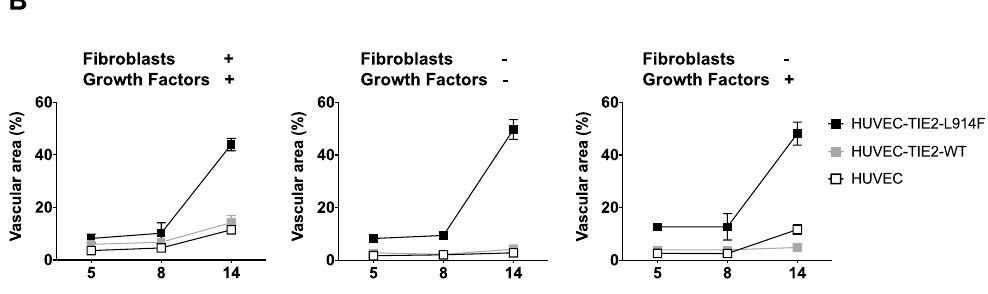
To characterize the ectatic vascular channels formed by the HUVEC-TIE2-L914F, we assessed the locali- zation of Podocalyxin and Collagen IV. HUVEC and HUVEC-TIE2-L914F were embedded in fibrin gels and while in normal HUVEC Podocalyxin localizes at the luminal (apical) side and Collagen IV at the basal side, in HUVEC-TIE2-L914F these polarity markers were aberrantly distributed (Figs 4B and Supplemental S4). Expression of the luminal markers Podocalyxin and ICAM2 36 in the TIE2-mutant EC was increased compared to control EC, HUVEC and HUVEC-TIE2-WT (Figs 4C and Supplemental S5). These data suggest that abnor- mal establishment of apico-basal polarity during lumen formation and overexpression of Podocalyxin in the mutant-EC may play a role in ectatic lumen formation. EC expressing constitutive active mutant TIE2 form channels with scarce recruitment and contact with pericytes, akin to patients’ VM lesions. VM vascular channels are characterized by scarce and irregu- lar pericyte recruitment 18,20,37 . We sought to investigate if the fibrin gel system could mimic this important aspect of the VM aberrant vascular formation. Fibrin gels were assembled with Cytodex ® beads coated with a mixture of EC